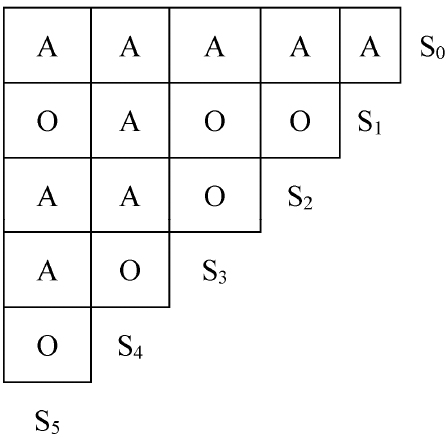
Figure 3. Logical relationships among in fl uencing factors.